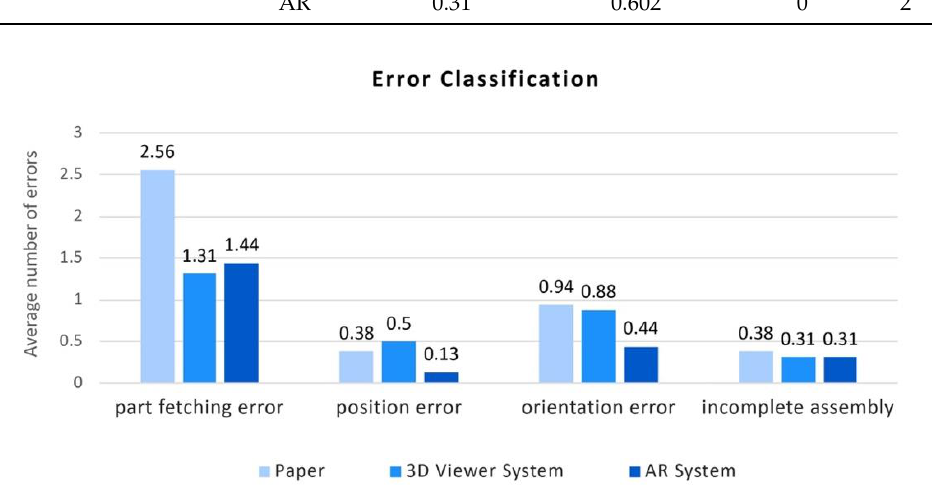
Table 8. NASA-TLX sub-scores of the three